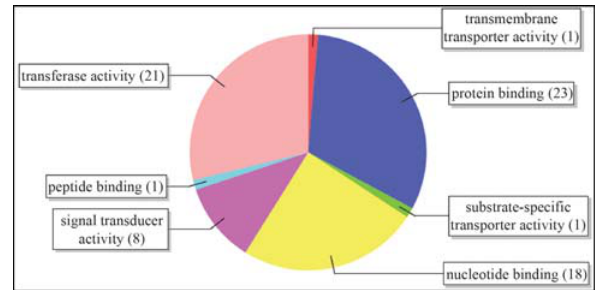
Figure 3 - Distribution of GO terms in the Molecular Function category, level